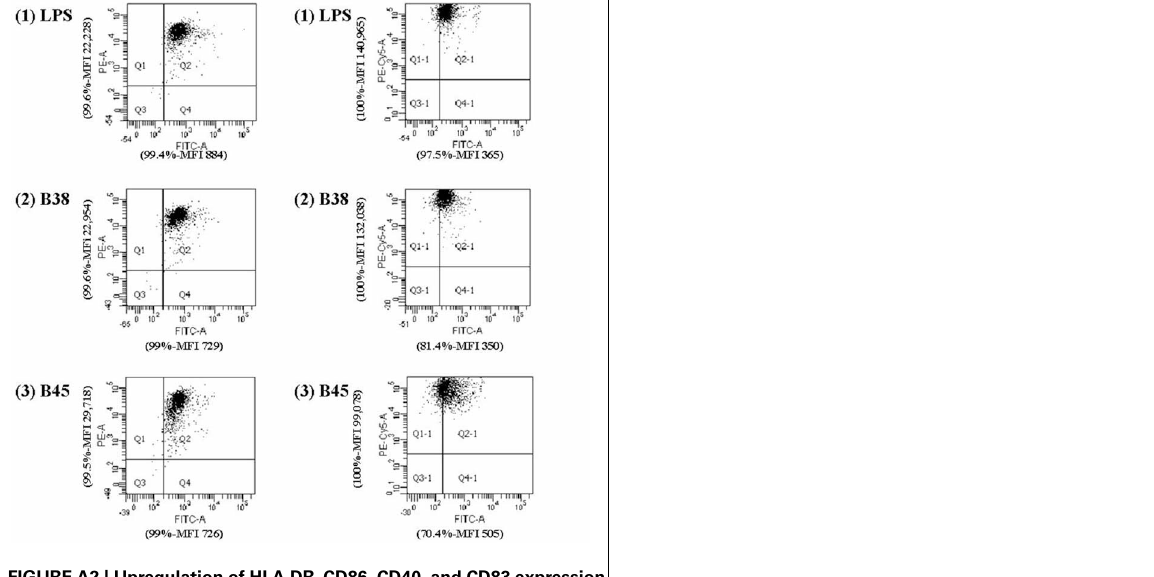
FIGURE A2 | Upregulation of HLA-DR, CD86, CD40, and CD83 expression in activated dendritic cells. Dot plots on the left side of the figure correspond to DCs stained with C83-FITC and CD86-PE antibodies and dot plots on the right side to DCs stained with C40-FITC and HLA-DR-PECy5 antibodies. E. coli LPS (LPS, 100ng/ml) was used as the positive control. For each activation marker, the percentage of positive cells and mean fluorescence intensity (MFI) are indicated on each corresponding axis and are representative of the data obtained for one experiment out of 13 performed for H. pylori strain B38 and strain B45. (PE: phycoerythrine, PECy5: phycoerythrine-cyanine 5, FITC: fluorescein isothiocyanate).